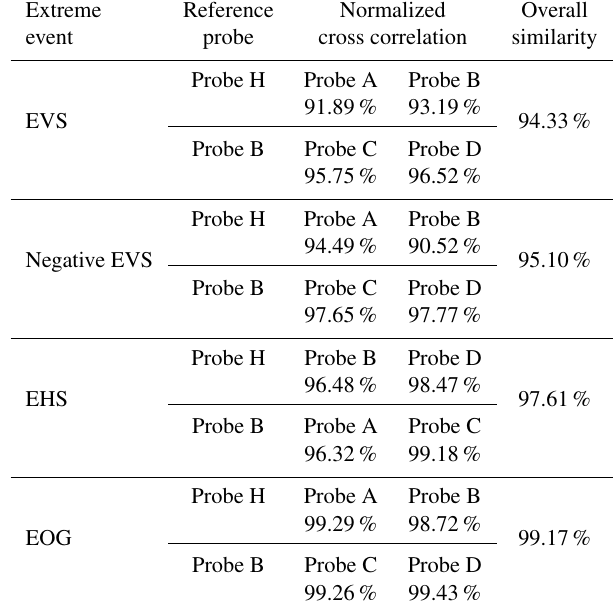
Table 4. The reproducibility analysis based on probes H and B from the previous study (Shirzadeh et al.,